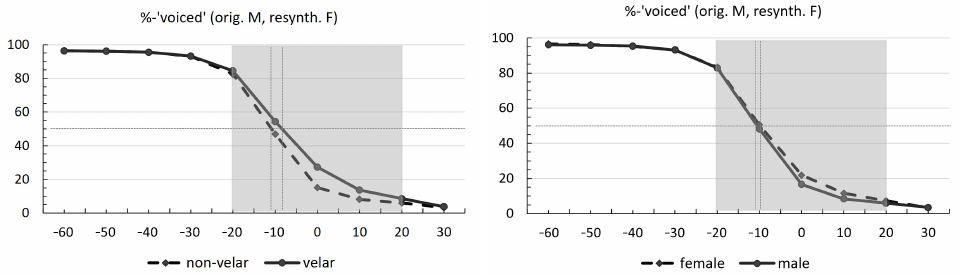
Figure 4. Identification curves for the original voice (male) and resynthesized voice (female) tokens identified as ‘voiced’ across 10 VOT levels. Left: non-velars (dashed line) vs. velars (solid line). Right: female voice (dashed line) vs. male voice (solid line). Thin dotted lines mark the 50% boundary. Statistical modeling was conducted on the area highlighted in